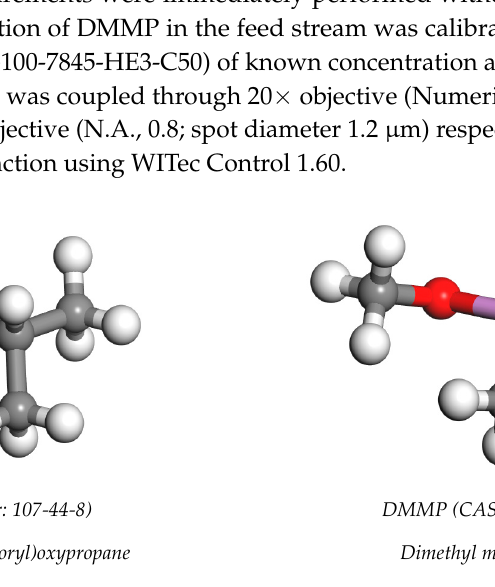
Figure 3. Structural analogies of Sarin and dimethyl methylphosphonate (DMMP) surrogate. Color legend: P, purple; F, blue; C, grey; O, red; and H, white.